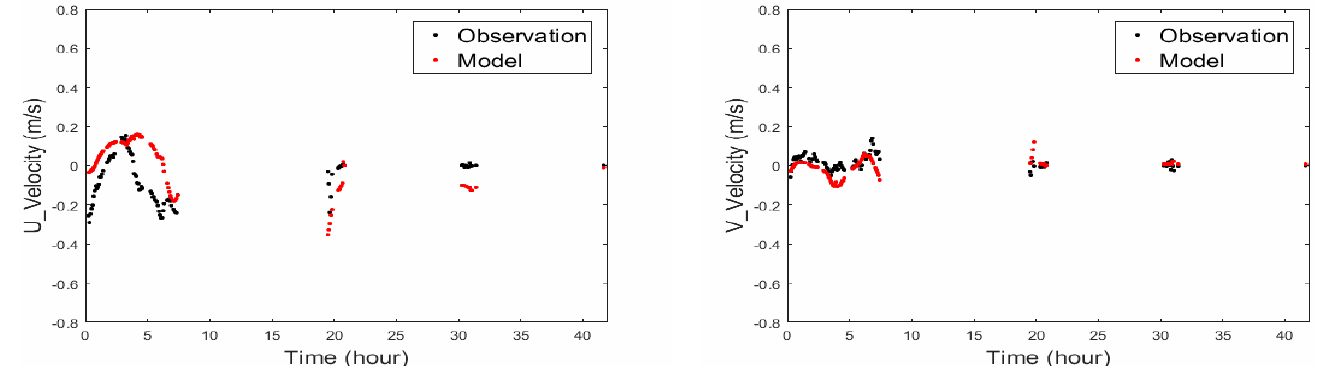
Figure 9. Time series velocities comparison between observed SCT1 drifter data and FVCOM data. U-velocity is on the left , and V-velocity is on the right .